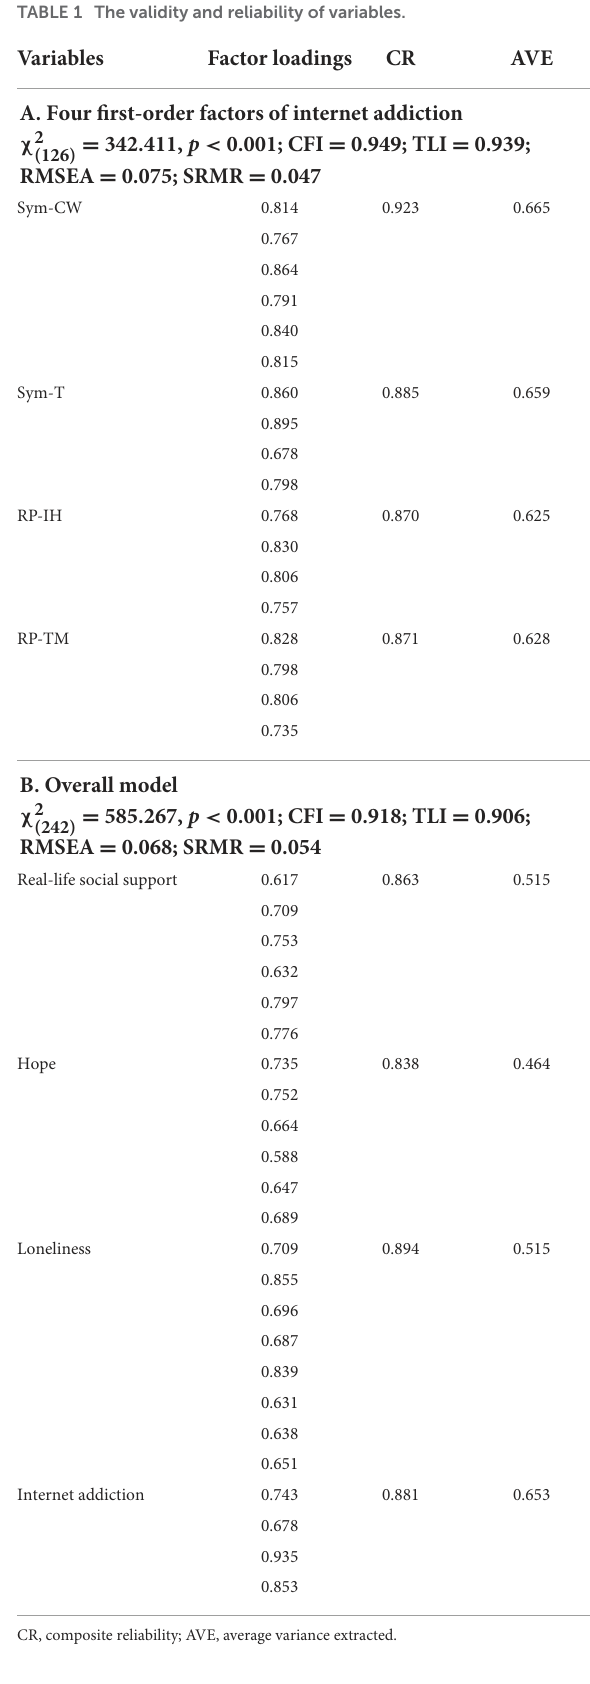
TABLE 1 The validity and reliability of